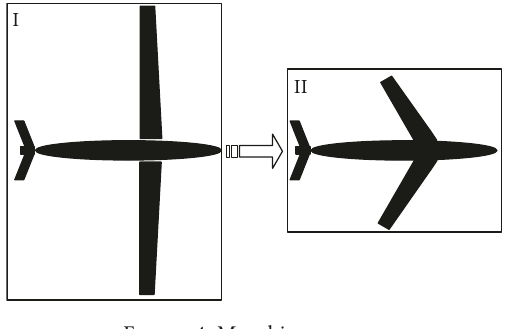
Figure 4: Morphing